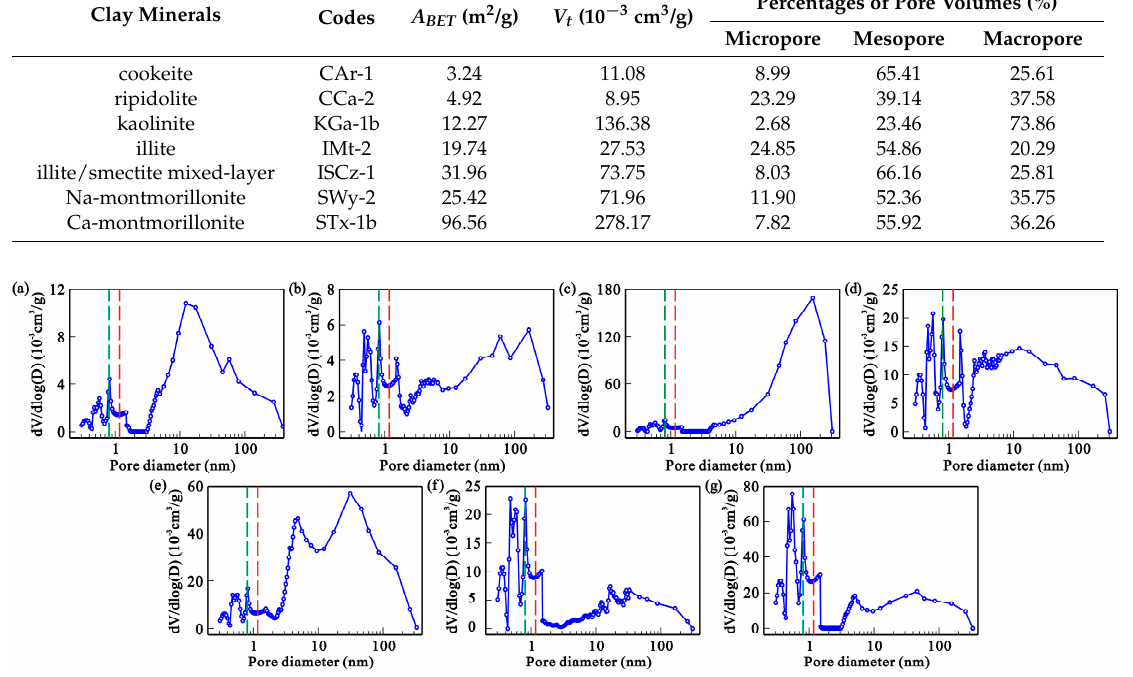
Figure 5. Pore size distribution for clay minerals from LT-N 2 A/D and LP-CO 2 A tests ( a – g : cookeite, ripidolite, kaolinite, illite, illite/smectite mixed-layer, Na-montmorillonite and Ca-montmorillonite; green short dash line: Pore diameter = 0.82 nm; red short dash line: Pore diameter = 1.17 nm).